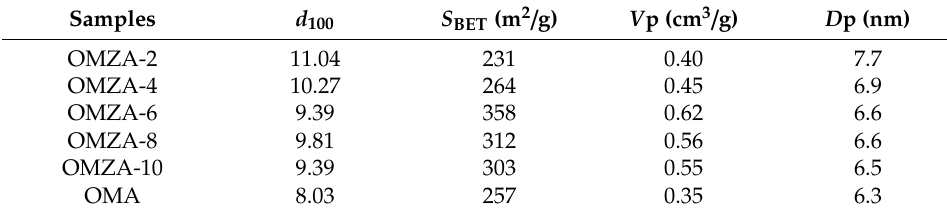
Table 1. The textural properties of samples OMZA-x and OMA. a